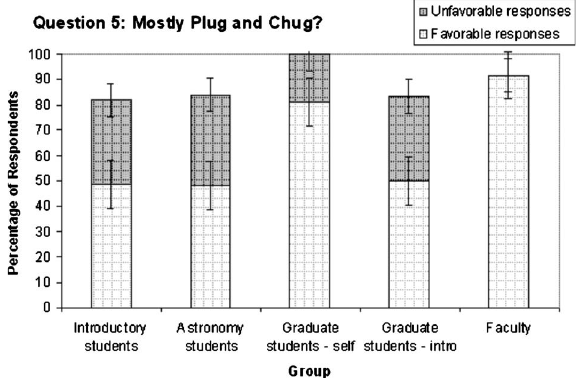
FIG. 5. Histogram showing favorable (cid:1) agree (cid:2) and unfavorable (cid:1) disagree (cid:2) responses for survey question (cid:1) 14 (cid:2) . While the trend in the figure from introductory students to faculty may appear to be incon- sistent with expectations, some faculty in individual discussions noted that they do not explicitly think about concepts that underlie the problem “while” solving problems because the concepts have become obvious to them. The introductory students often do not think about concepts because they believe in a plug and chug ap- proach to problem solving in